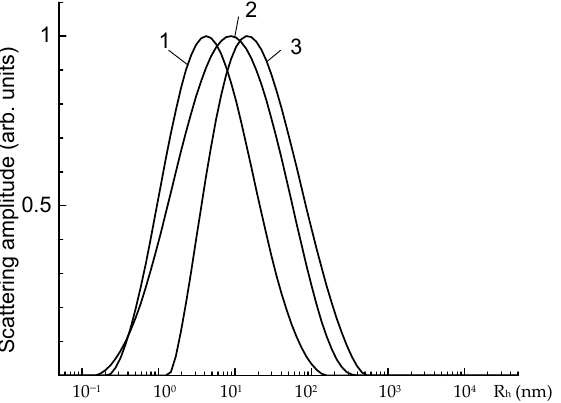
Figure 2. Hydrodynamic radius distribution of scattering particles for the CdSe QDs toluene sol (1), mixture of CdSe QDs—M1 with composition Z of mixture 0.1 (2) and 0.065 (3).